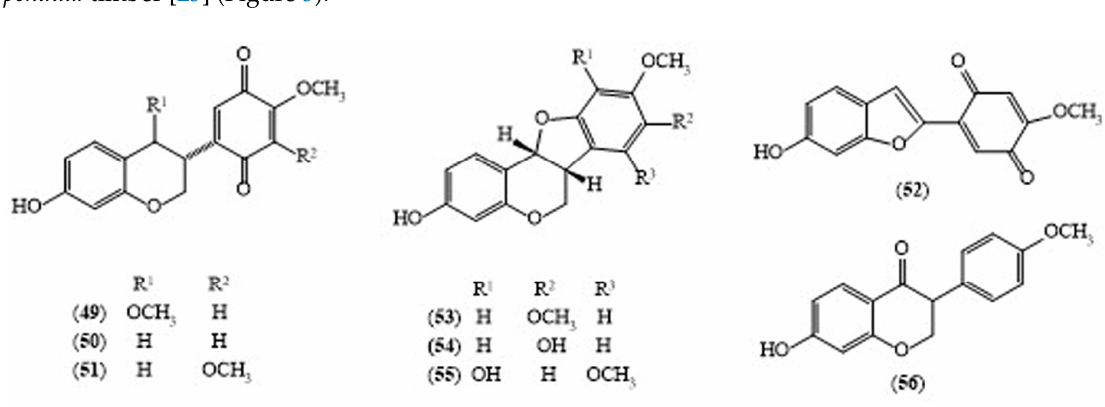
Figure 5. Structures of selected compounds isolated from Millettia pendula.